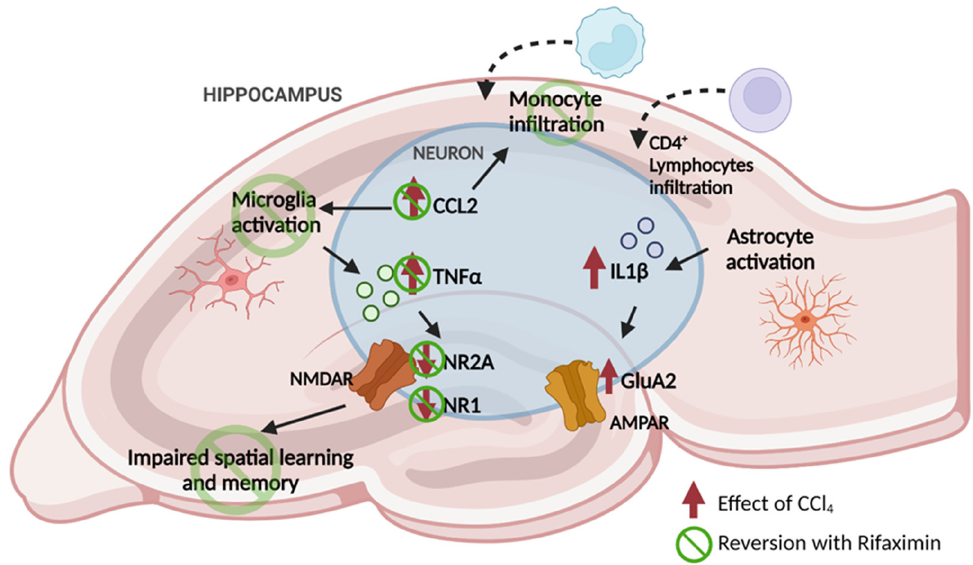
Figure 6. Proposed mechanisms leading to the impaired learning and memory in rats with mild liver damage. These results suggest that the increase in CCL2 in the hippocampus would be an early event in the process leading to cognitive impairment in rats with mild liver damage. The increase in CCl2 would promote both the infiltration of monocytes into the hippocampus to became macrophages and the activation of microglia. Microglia activation in turn would contribute to the increase in TNF α in hippocampal neurons of these rats, leading to the reduced membrane expression of NR1 and NR2A subunits of NMDA receptors which, in turn, would lead to the impairment in spatial learning and memory. All this process is reversed by treatment with rifaximin, that restores cognitive function in rats with mild liver damage. Mild liver damage also triggers infiltration of CD4+ lymphocytes, activation of astrocytes, increased levels of IL-1 β and enhanced membrane expression of the GluA2 subunit of AMPA receptors in the hippocampus. These changes are not reversed by treatment with rifaximin. Created with BioRender.com.